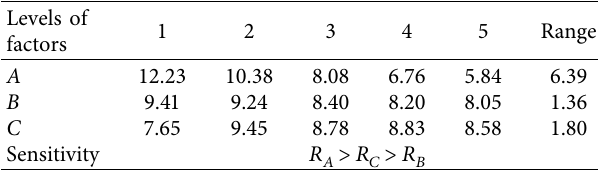
Figure 13: Evolution laws of different parameters: (a) evolution laws of density; (b) evolution laws of uniaxial compressive strength; (c) evolution laws of elastic modulus; (d) evolution laws of tensile strength. Table 9: Sensitivity analysis of density to three factors. Table 10: Sensitivity analysis of uniaxial compressive strength to three factors. Levels